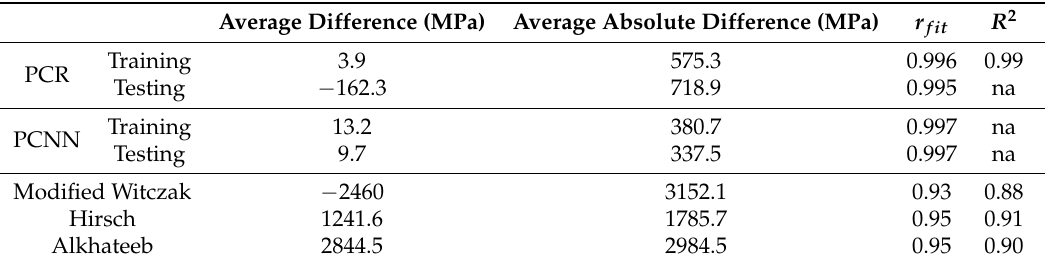
Table 6. Performance Comparison of the Developed and Existing Models using Statistical Analysis (na*: not applicable. R 2 is applicable to models with linear parameters and thus it is not applicable to PCNN due to the non-linear nature of its parameters.).